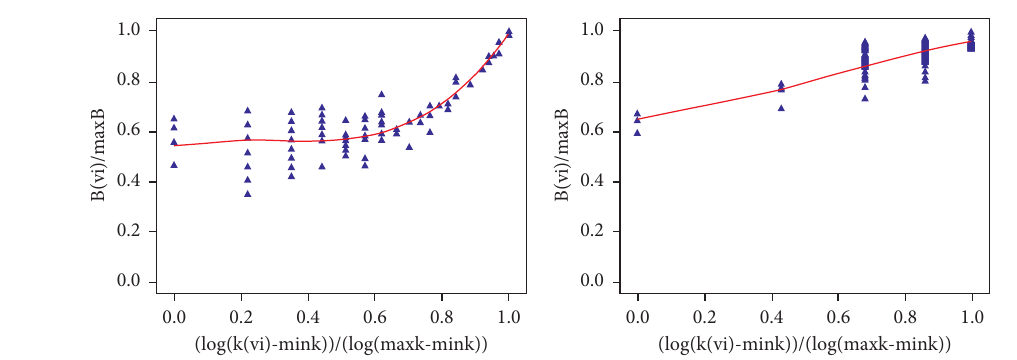
Figure 6: The balance distribution of nodes in a small graph. Table 5: Running time (unit: